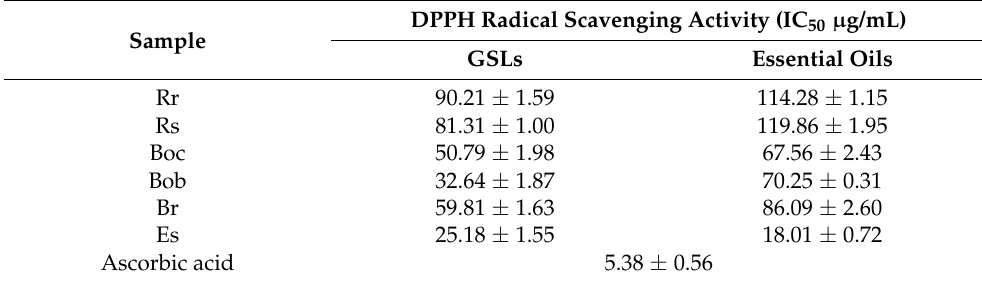
Table 4. DPPH radical scavenging activity of GSLs and essential oil of the studied Brassiccaceae